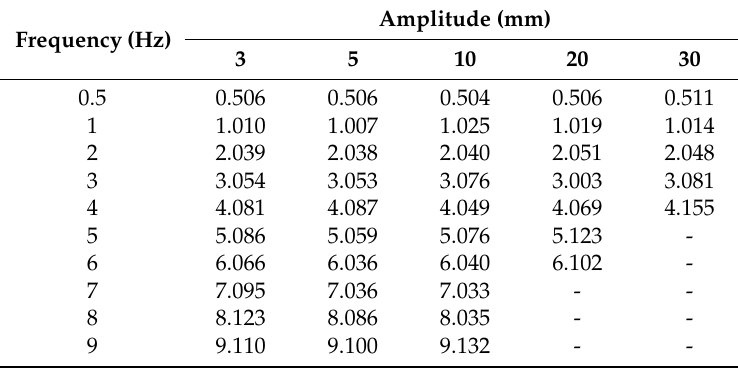
Table 2. Measured frequencies of oscillations of different